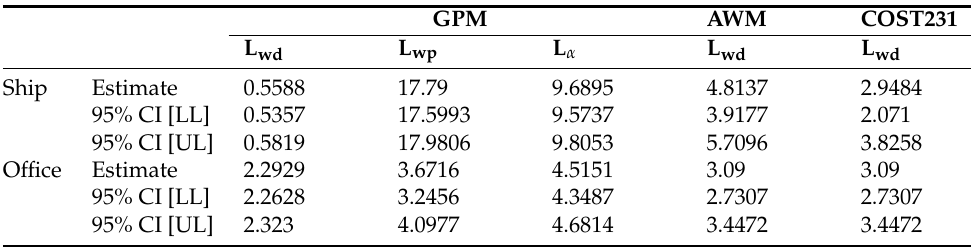
Table 2. GPM, AWM and COST231 model coefficients for 868 MHz in a ship and office room environment, fitted using a multivariate non-linear least squares algorithm. The bold values indicate the coefficient estimates, accompanied by the lower limits (LL) and upper limits (UL) for the 95% confidence intervals